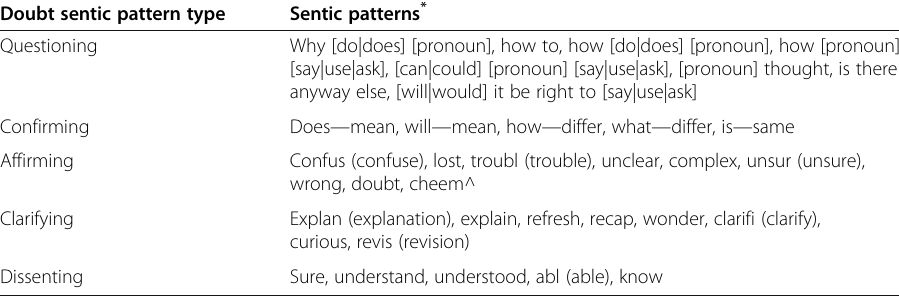
Table 2 Doubt sentic patterns type and its associated sentic patterns Doubt sentic pattern type Sentic patterns